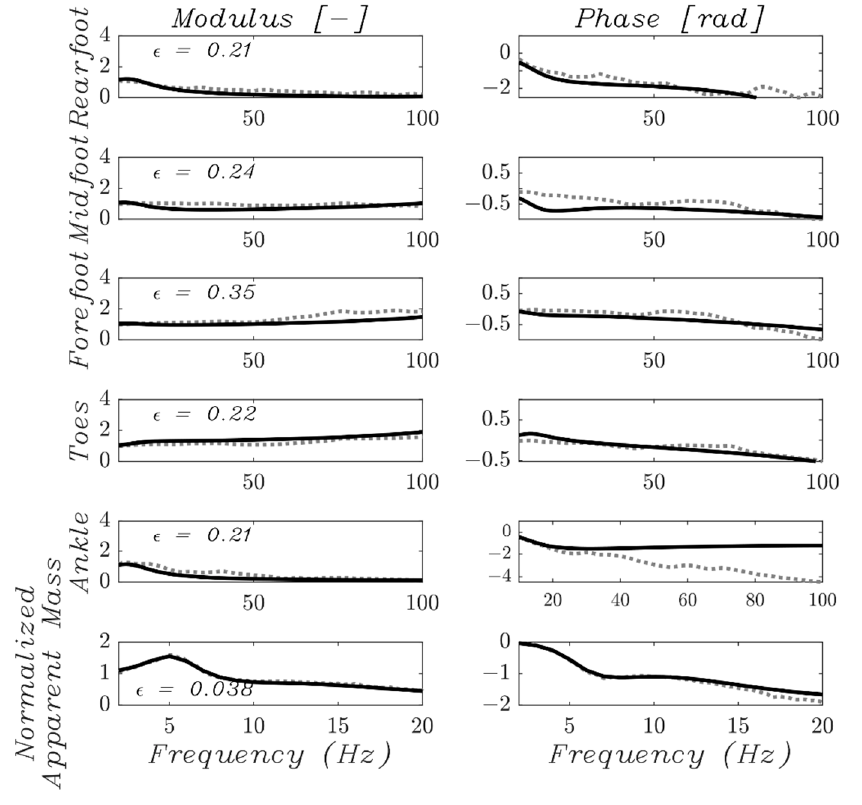
Figure 4. Simulated (black curves) and experimental (grey curves) amplitude and phase of five transmissibility and the apparent mass of one subject in natural standing posture. The reconstruction errors ( ε m and ε m ) are also reported for each amplitude. AM T , i